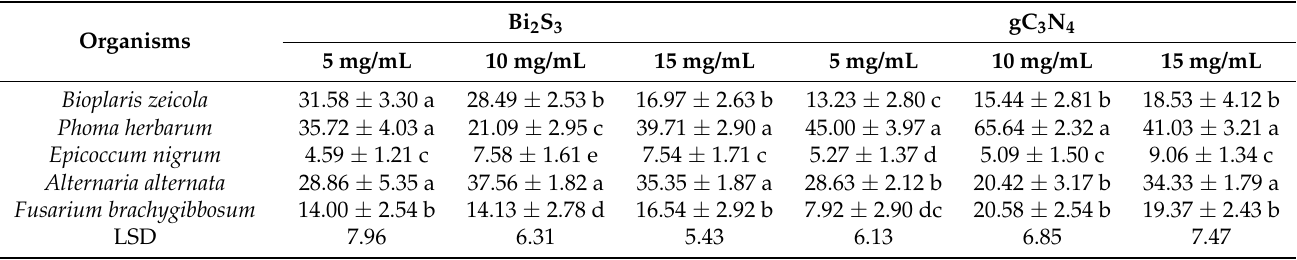
Table 2. Percentage inhibition of different concentrations of nanoparticles on the growth of some pathogenic fungi.